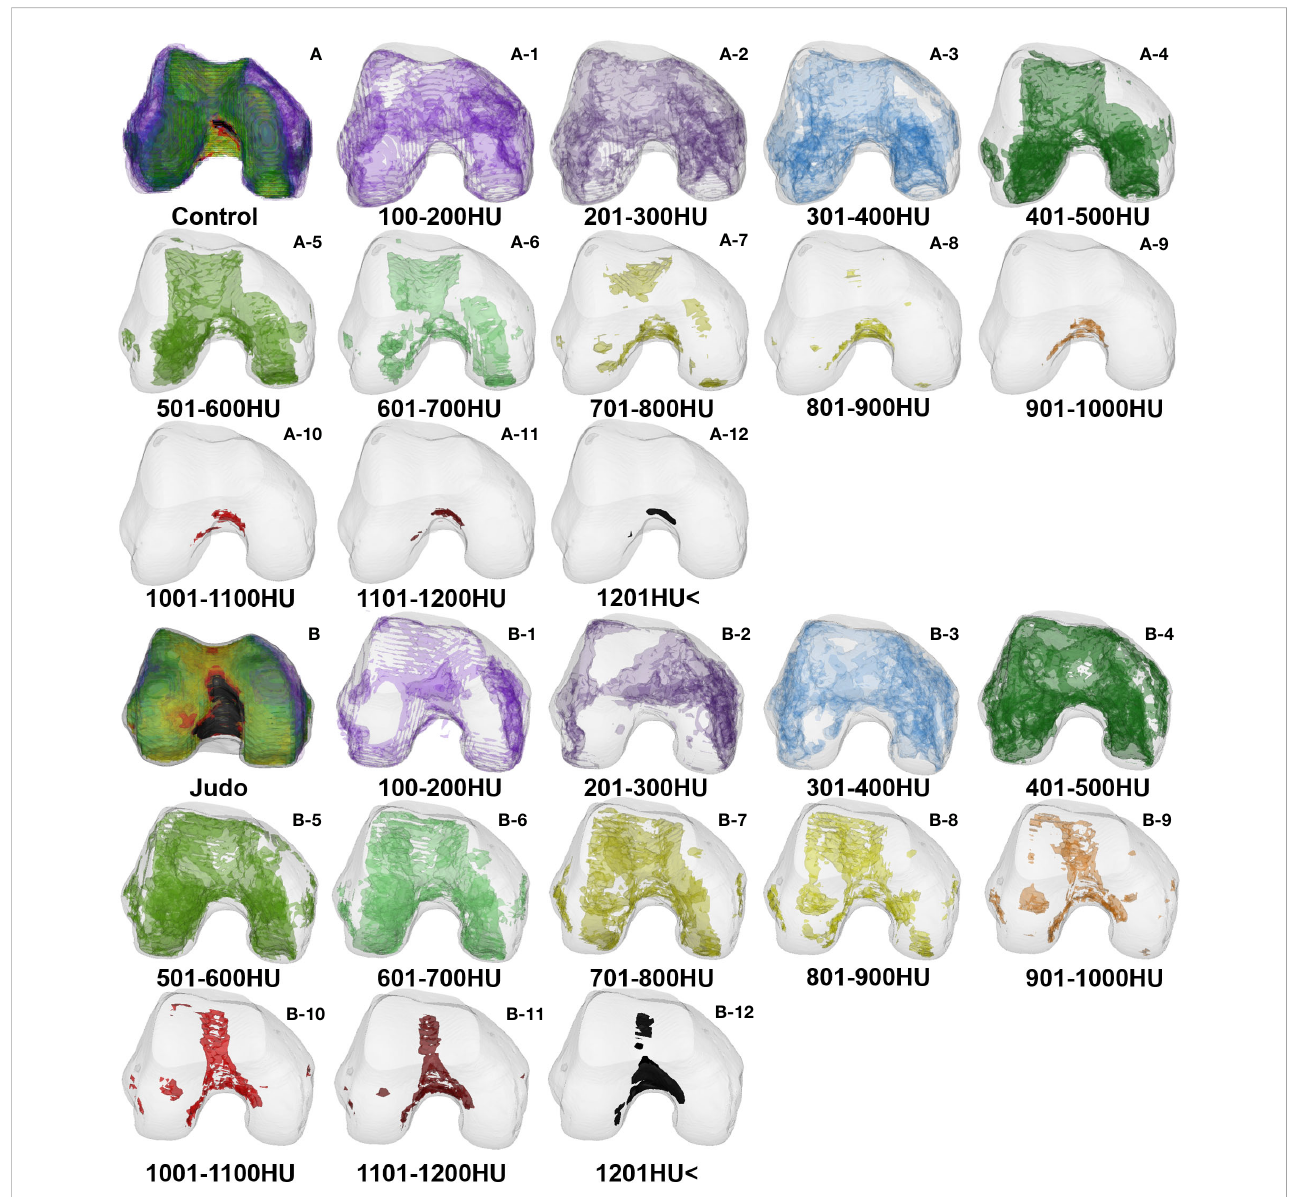
FIGURE 5 Bone tissue volume distribution of bone densities in the distal femur: (A) Control group (A-1 – A-12) and (B) Judo group (B-1 – B-12)